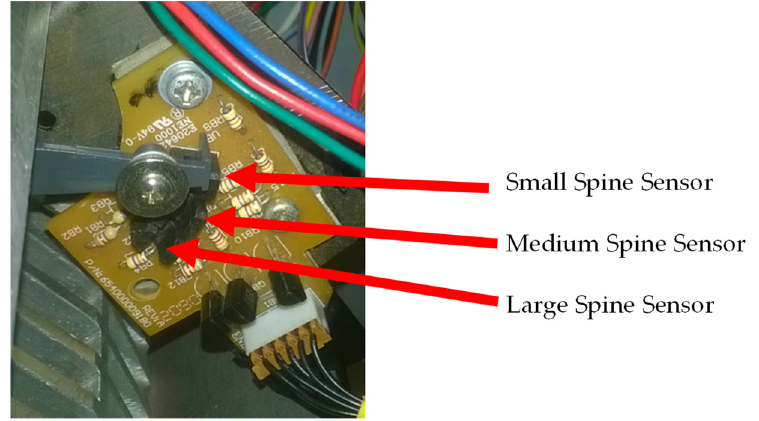
Figure 6. Inserted spine measurement mechanism indicating the size of each spine